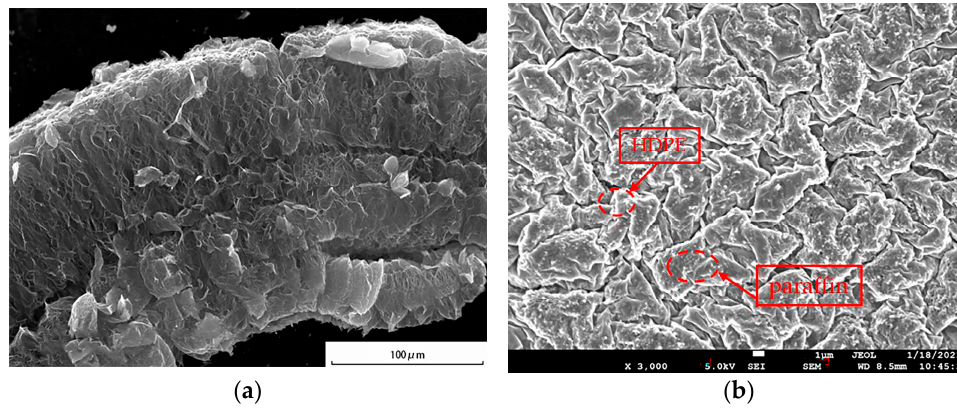
Figure 3. The SEM photographs of ( a ) EG and ( b ) the SSPCM.